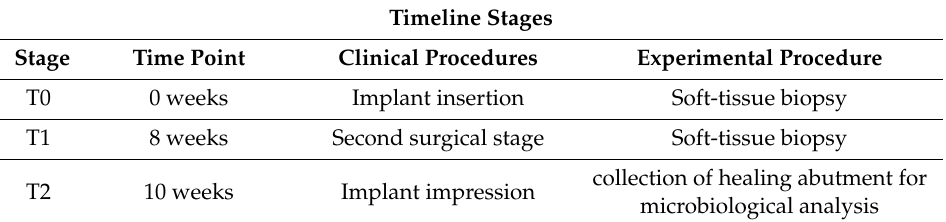
Table 1. Timeline of stages